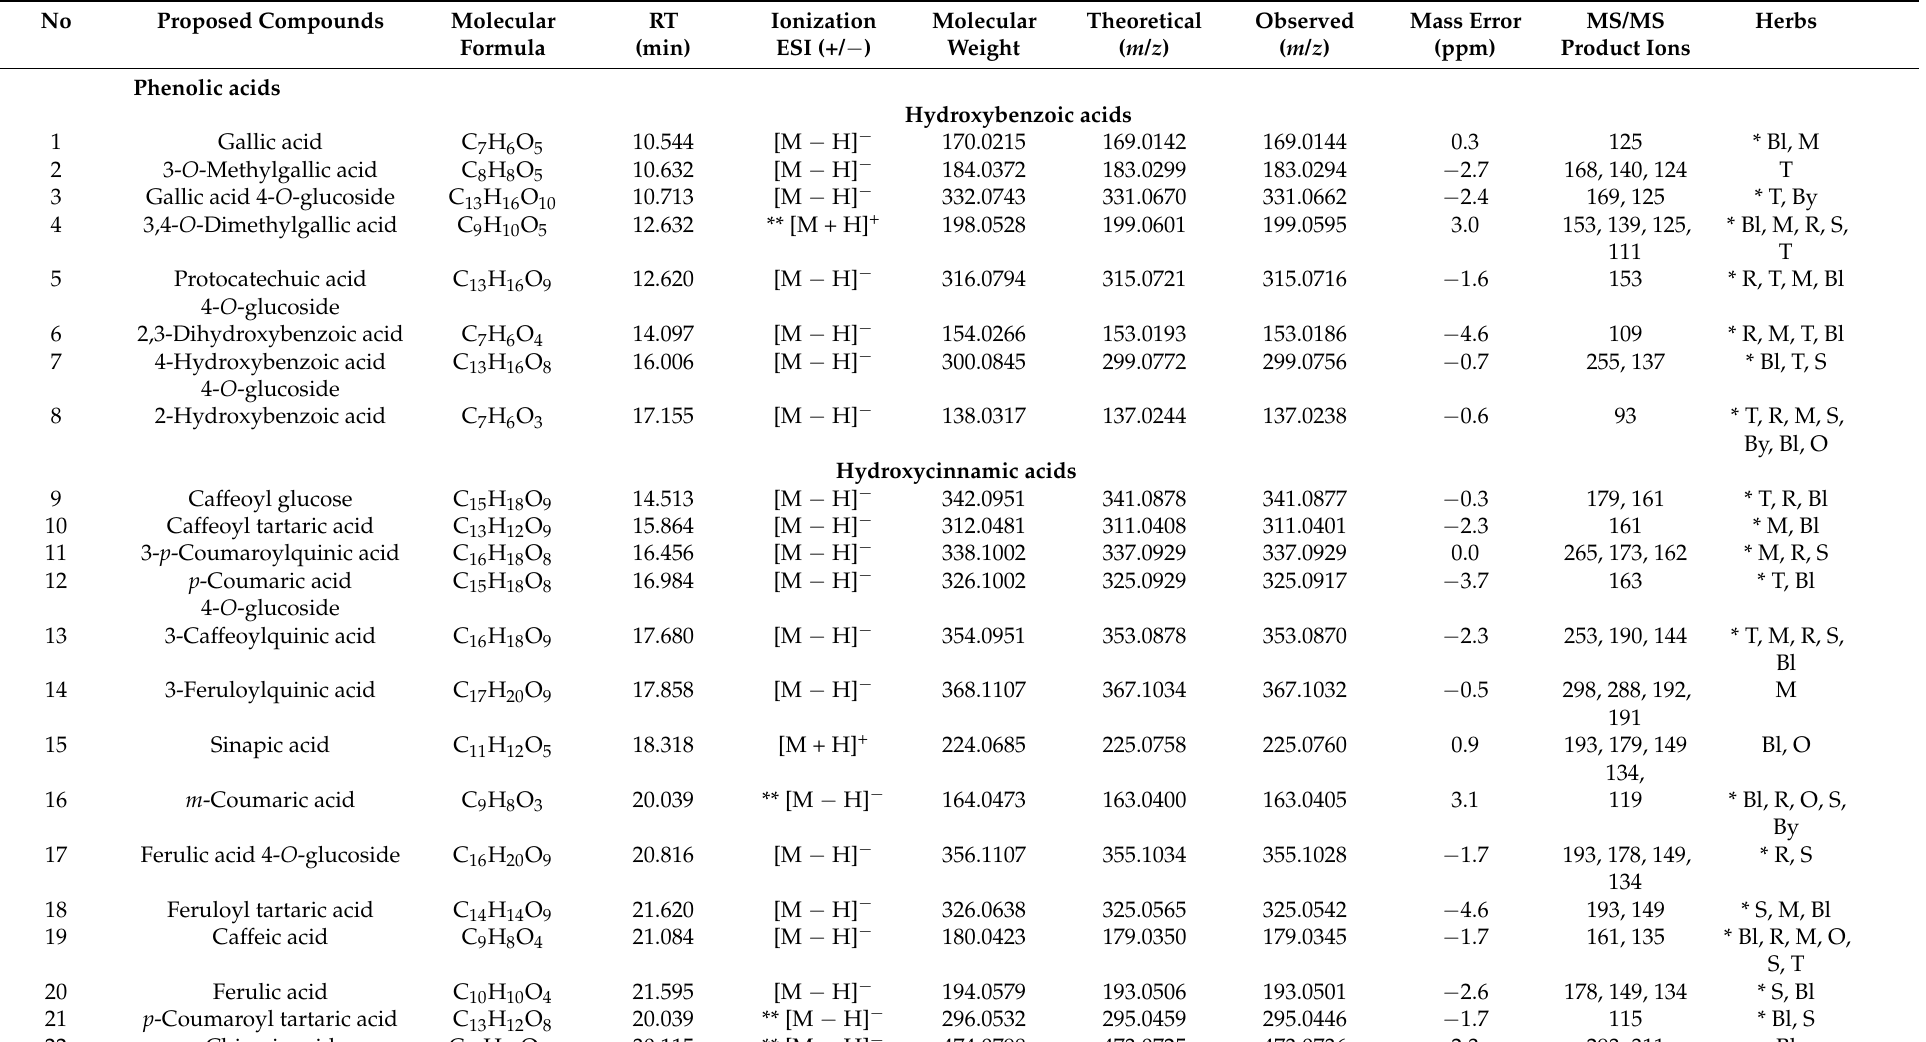
Table 3. Characterization of polyphenolic compounds from Australian-grown herbs by